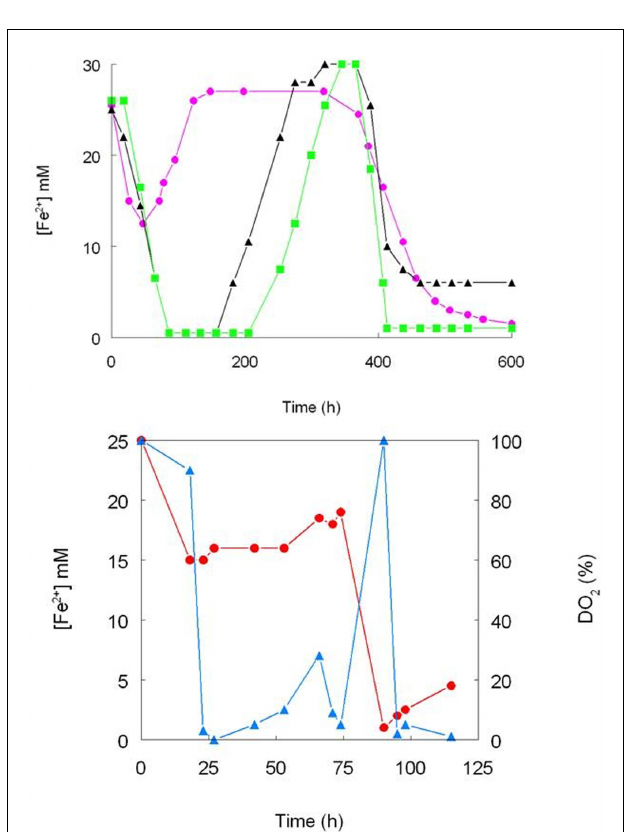
FIGURE 4 | Iron cycling by pure cultures of moderately thermophilic acidophiles. (Top) - (cid:2) - Sb. thermosulfidooxidans (strainTH1), - (cid:3) - Sb. • acidophilus (strainTHWX), - - Acidimicrobium sp. (strain HPTH; all cultures grown in pH 2.0 medium containing 25mM ferrous sulfate, 10mM glucose and 0.02% yeast extract; no aeration control); (bottom) the effect of controlling concentrations of dissolved oxygen iron cycling by Sb. acidophilus (strainTHWX) grown at pH 2.0 in a medium containing 25mM ferrous sulfate, 10mM glycerol and 0.02% yeast extract; ferrous